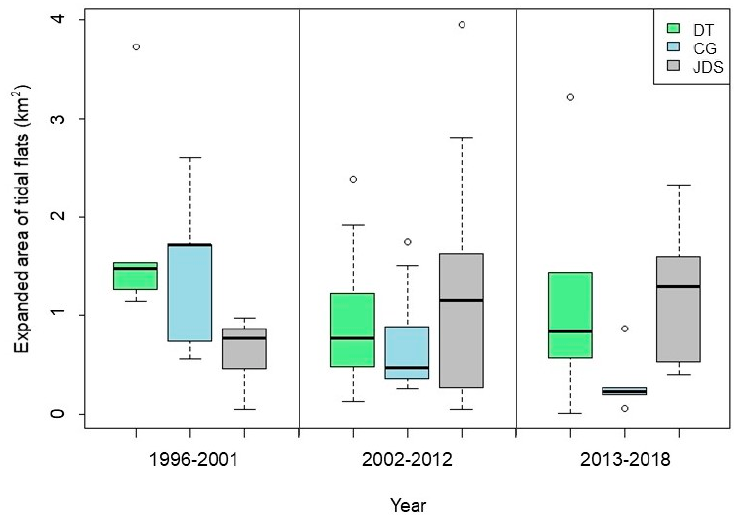
Figure 9. Expanded tidal flats area of sample boxes in three periods: 1996–2001, 2002–2012, and 2013–2018.